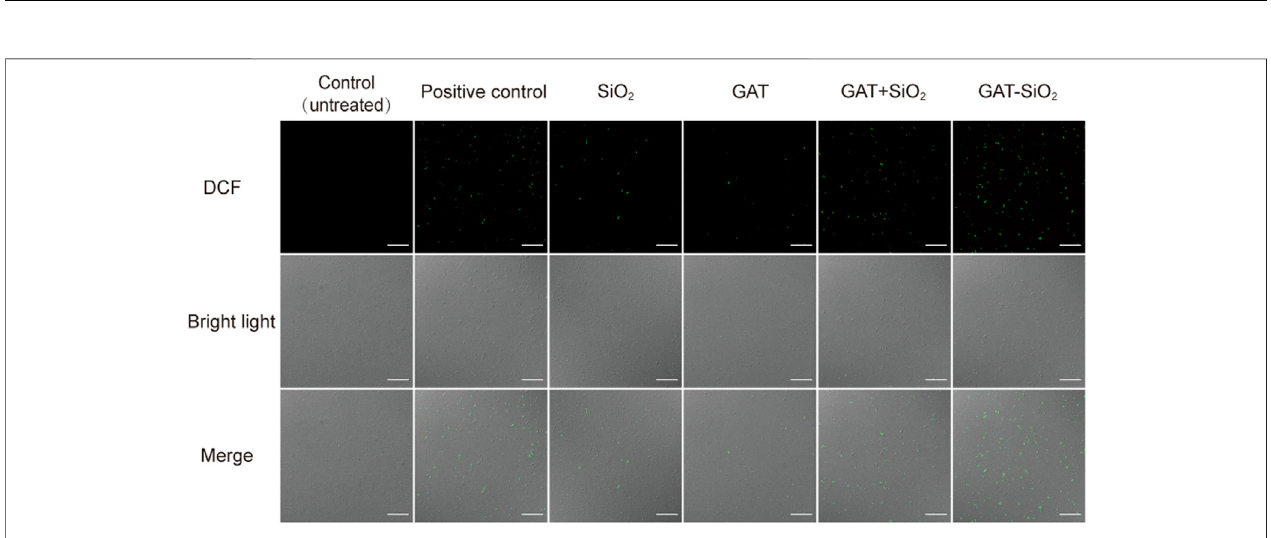
FIGURE 6 | SEM images of E. coli in different treatment groups. (A) Control. (B) SiO 2 NPs. (C) Gati fl oxacin. (D) GAT-SiO 2 NPs. Scale bar represents 30 μ m.